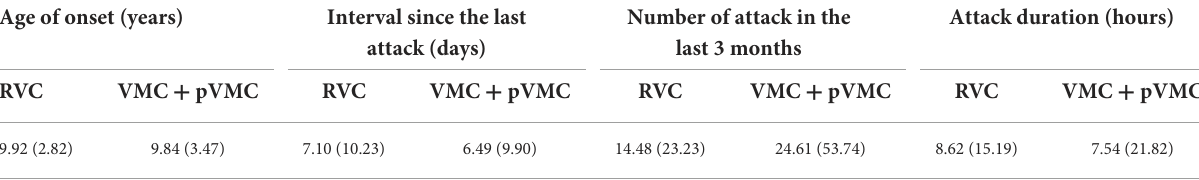
TABLE 5 Symptomatological